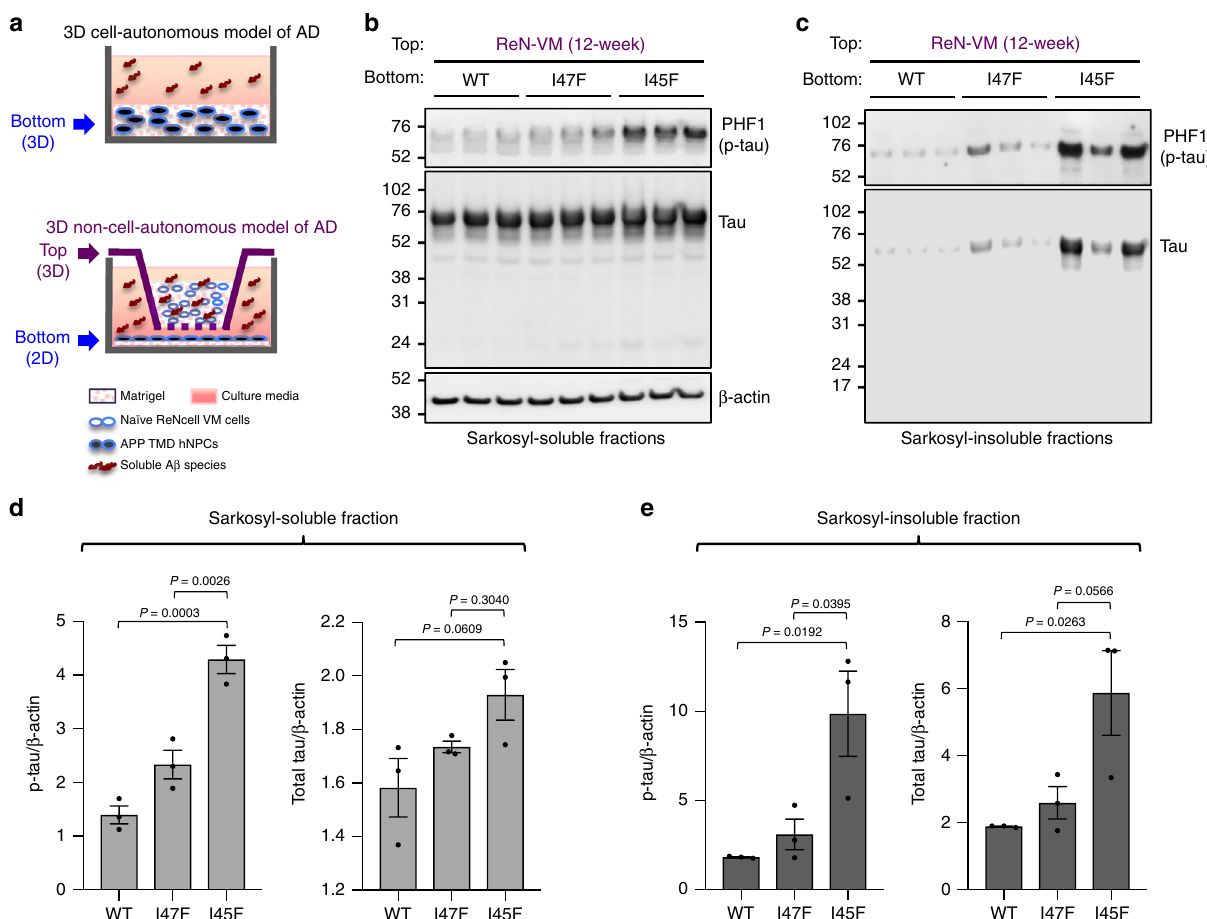
Fig. 6 A β 42/40 ratio regulates tau pathology in naïve hNPCs without FAD mutations. a Schematic illustrations of conventional 3D cell autonomous (top panel) and 3D non-cell autonomous (bottom panel) culture models of AD. Both thick-layer 3D cultures of naïve hNPCs (ReNcell VM) (2.5 × 10 6 ) plated in cell culture inserts (labeled with top) and 2D-plated APP TMD mutant cells (5 × 10 5 ), APP-WT, I47F, and I45F, respectively, in 24-well plates (labeled with bottom) are differentiated for a week separately. To prepare the non-cell autonomous 3D cultures, one-week differentiated cells are combined together in the same wells of 24-well plates, which differentiate for additional 12 weeks. b , c Naïve hNPCs co-cultured with APP TMD mutant cells for 12 weeks were dissolved in 1% sarkosyl lysis buffer to prepare sarkosyl-soluble ( b ) and sarkosyl-insoluble ( c ) fractions as described in Methods. The levels of p-tau (PHF1) and total tau were examined by Western blot analysis. β -actin was used as a loading control. d , e Relative levels of p-tau and total tau in sarkosyl-soluble ( d ) and sarkosyl-insoluble ( e ) were quanti fi ed using Fiji software. All values were normalized with β -actin levels. The results were combined to express as mean ± SEM of three independent repeats (black dots). Statistical signi fi cances were determined by one-way ANOVA with Tukey ’ s multiple comparisons